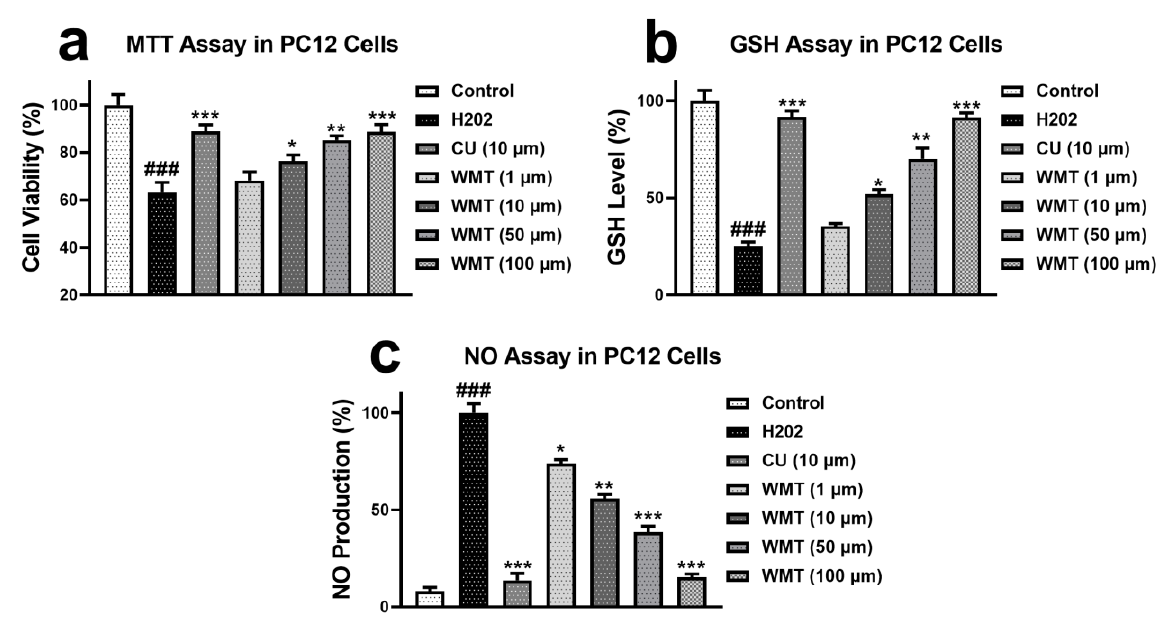
Figure 1. Effect of WMT (1, 10, 50, and 100 µ M) on the cell viability ( a ), GSH level ( b ), and NO production ( c ) in H 2 O 2 - induced PC12 cells. Cell viability was determined by the MTT assay. Data were obtained from the three sets of independent experiments and were expressed as the mean ± S.D. n = 3 independent experiments; each independent experiment consisted of 5 replicates. (*) p < 0.05, (**) p < 0.01, and (***) p < 0.001 indicates significant differences from the H 2 O 2 -treated group. (###) indicates a significant difference from the control